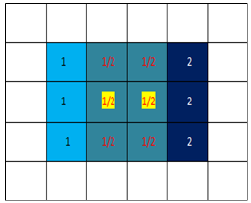
Figure 4. Diagram of overlapping with structural elements movement.